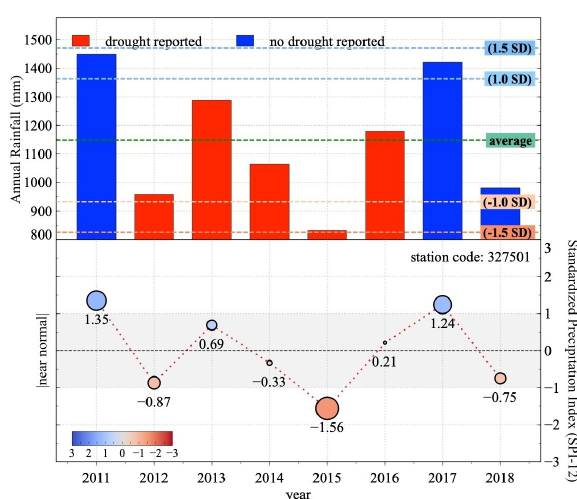
Fig. 12. Interpretation of SPI12 as drought indicator with the amount of annual rainfall and drought information at station Omkoi